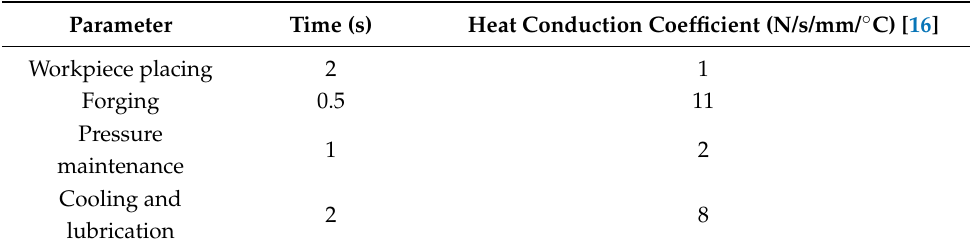
Table 2. Time and heat conduction coefficient of each stage in the forging